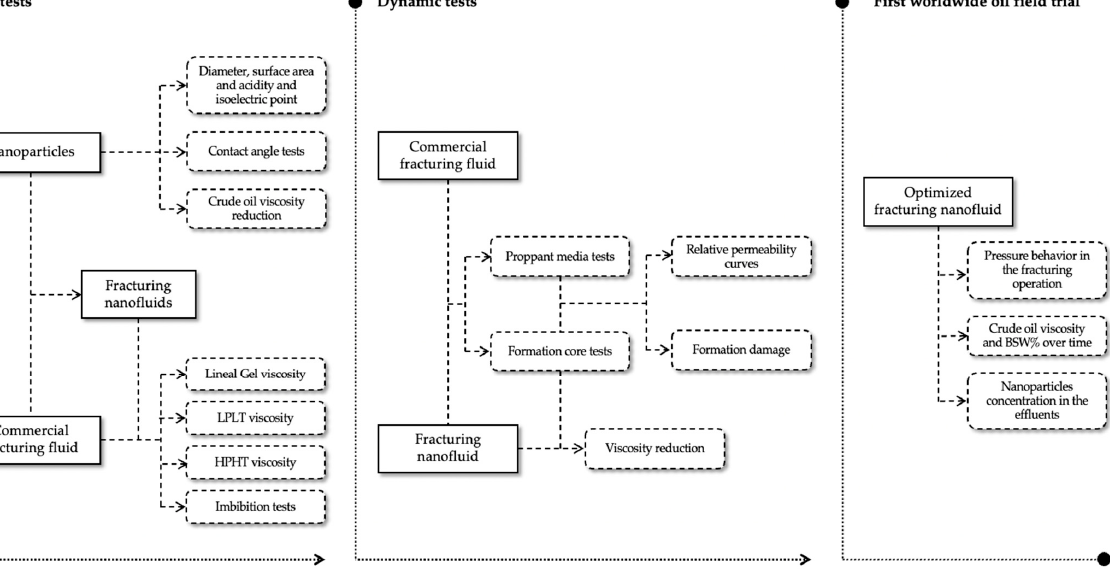
Figure 1. Experimental workflow for developing and testing a fracturing nanofluid from laboratory test to oil field trial.